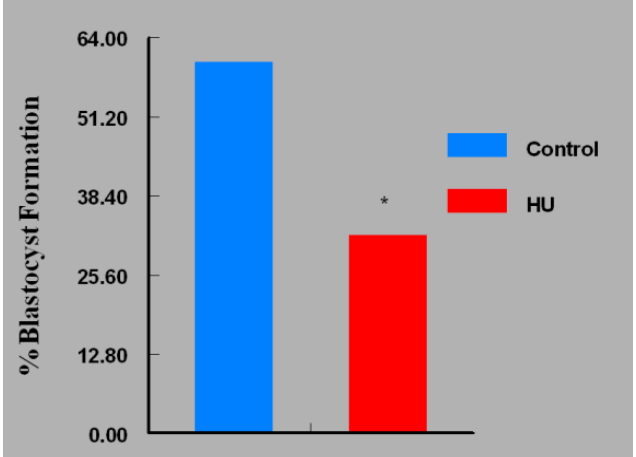
Figure 5. Effect of in vivo Exposure of Embryos to HU on Their Ability to Develop to Blastocyst Stage; n = 60 per Group. Results are expressed in percentages (HU = treated mice; Control = vehicle treated mice. Asterisks indicate a significant difference from controls ( P <